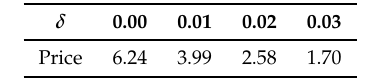
Table 3. HWB price estimates for r = 0.03 and varying δ .